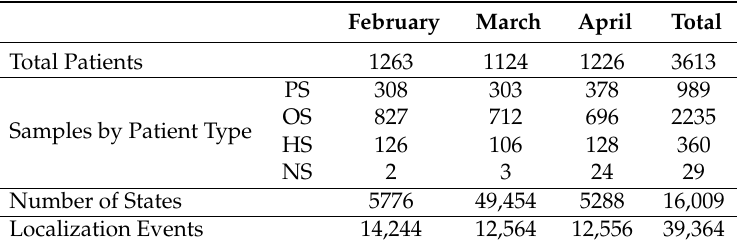
Table 1. Statistics of the corpus used for the experiment.